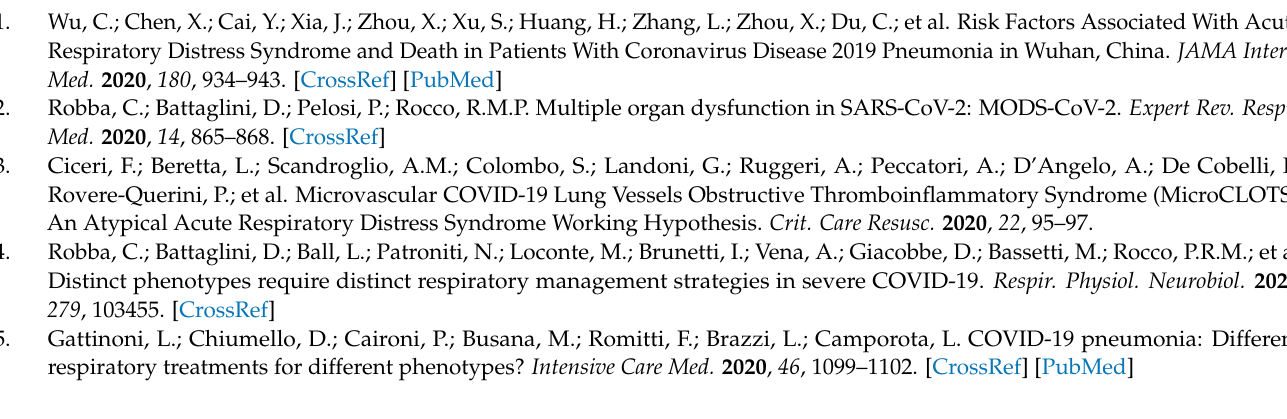
Figure S2: PaO 2 /FiO 2 response to CPT in the overall population of 66 severe COVID-19 ICU patients, Figure S3: Hemodynamic responses to RPT, Figure S4: Changes of PaCO 2 before and after